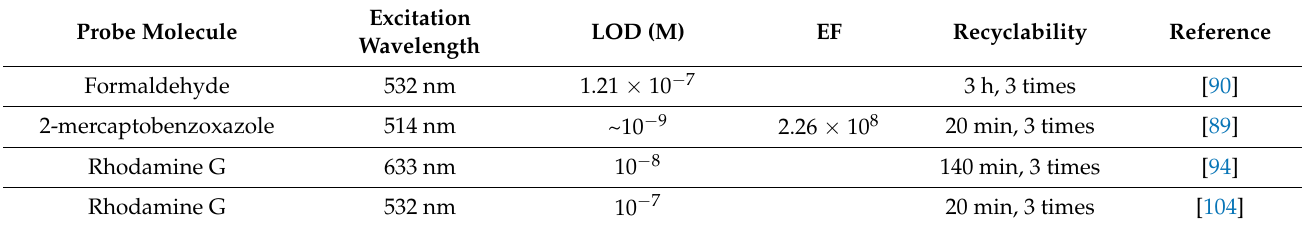
Table 2. SERS properties of Ag NPs/TiO 2 NTs